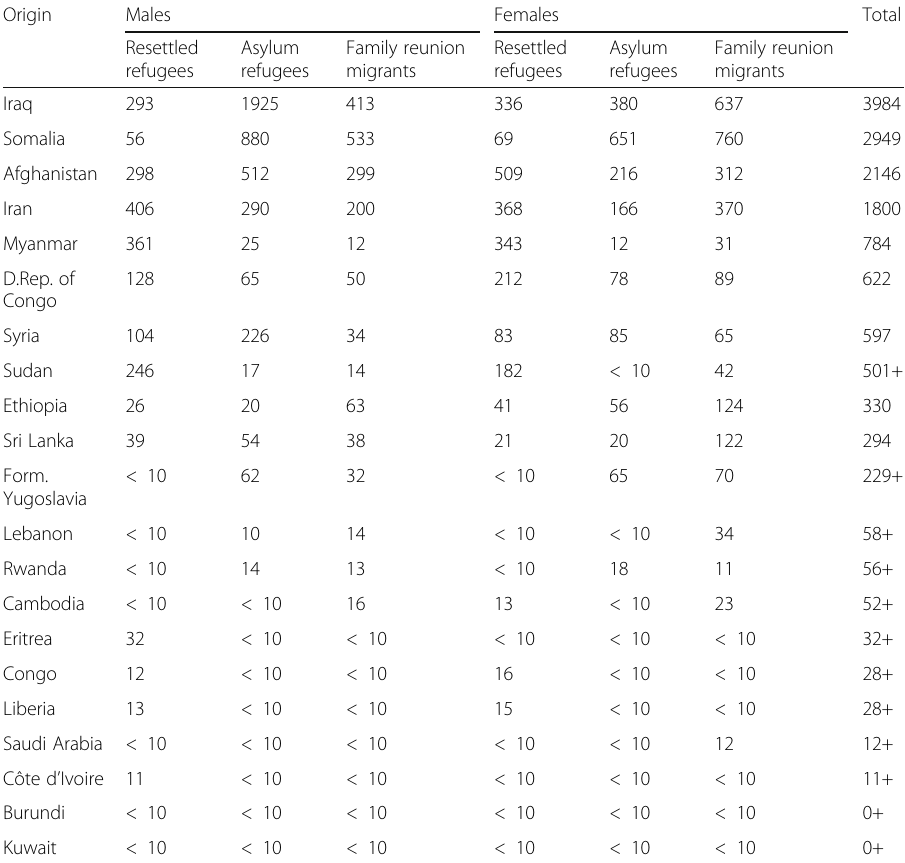
Table 2 The data frequencies by gender, admission category and the country of birth